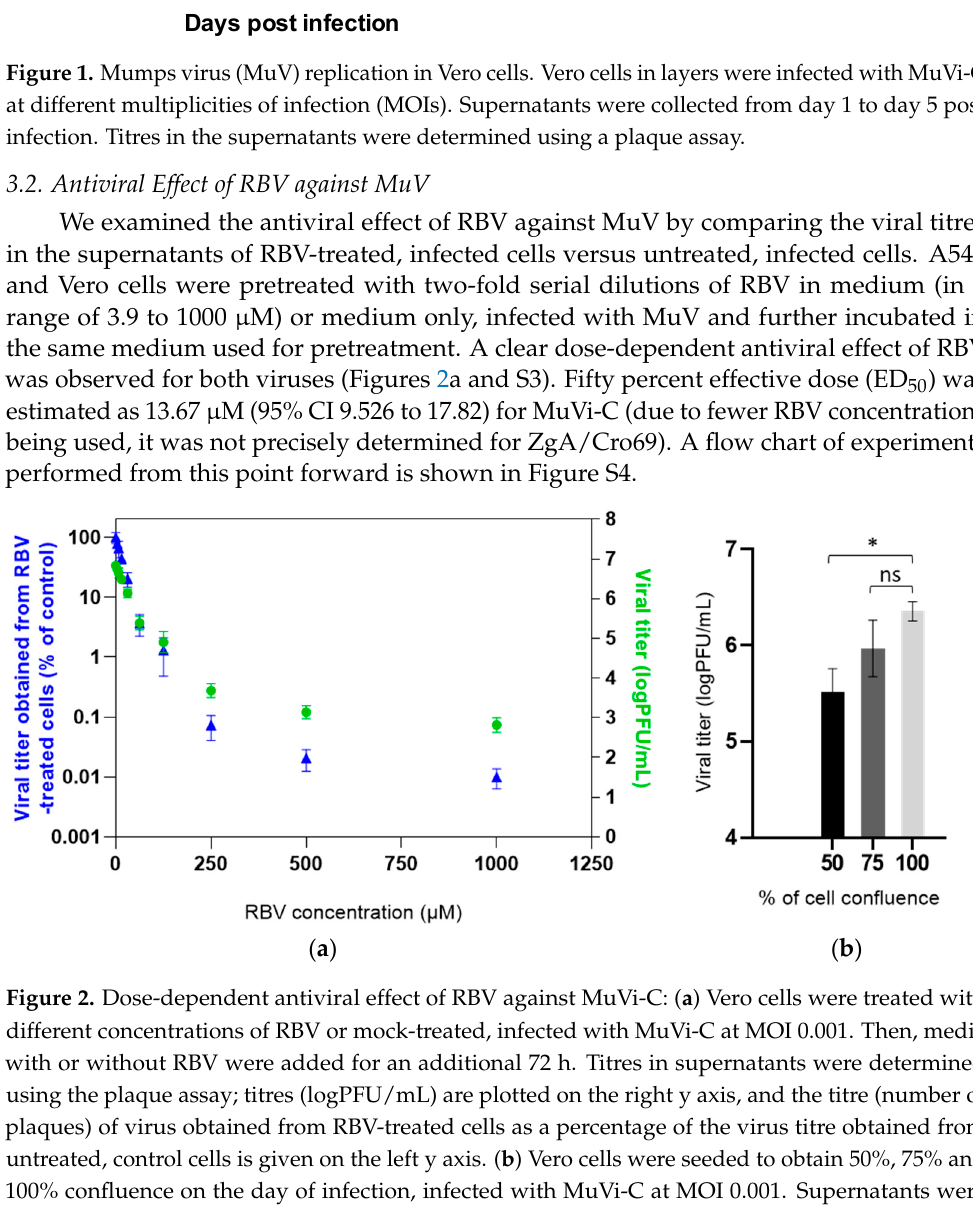
Figure 1. Mumps virus (MuV) replication in Vero cells. Vero cells in layers were infected with MuVi-C at different multiplicities of infection (MOIs). Supernatants were collected from day 1 to day 5 post infection. Titres in the supernatants were determined using a plaque assay.